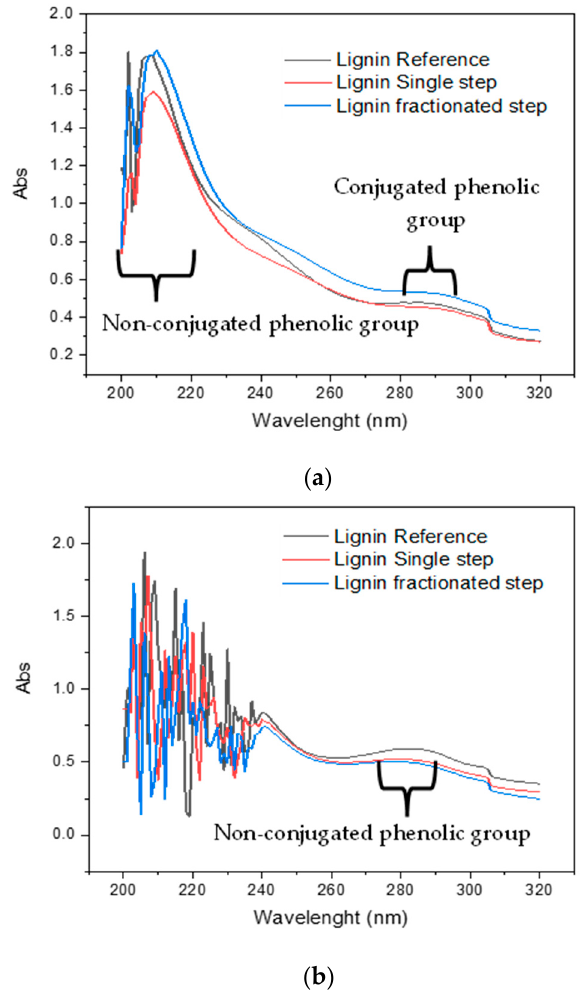
Figure 1. Lignin solubility in base ( a ) and organic solvent ( b ) determined by UV-Vis. A glance at Figure 1b reveals an identical UV-Vis spectrum among three lignin samples when lignin is diluted in dioxane/water. Unlike the lignin in the base solution, solubiliza- tion lignin in dioxane/water is limited to wavelengths above 250 nm seen in the spectra Figure 1b. This finding is similar to lignin Alfa grass kraft from industrial waste [31] and Kraft- anthraquinone (AQ) lignin [32]. According to Ammar et al.’s report, the large absorbance of lignin in dioxane/water at 280 nm corresponded to non-conjugated phenolic hydroxyl groups. In comparison, the presence of both ferulic acids and p-coumaric acids could be attributed to the presence of the second type region of lignin absorption at about 300 nm [31]. Lignin reference has slightly higher absorbance than isolated lignin regarding